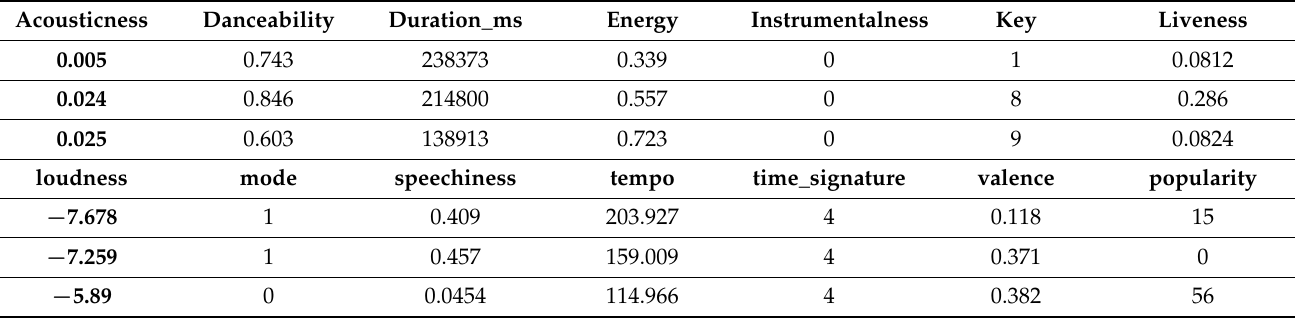
Table 2. Some of the imported data.